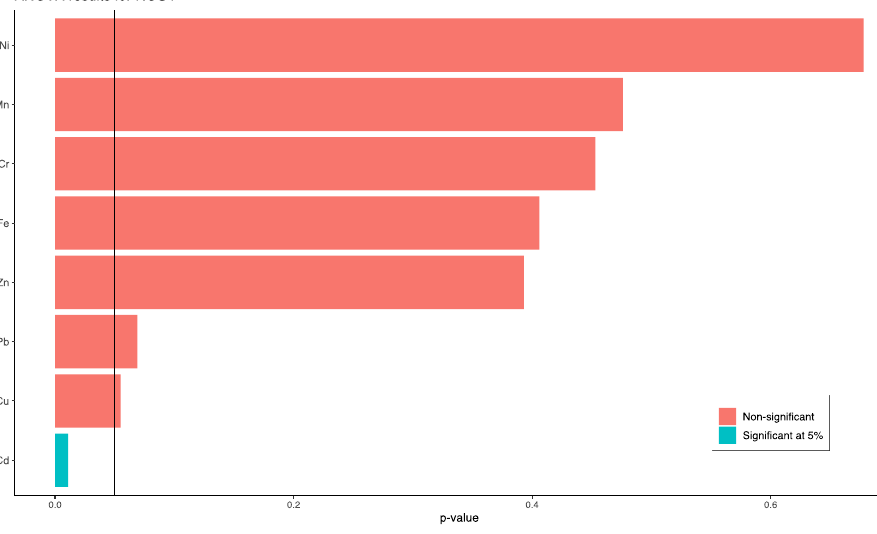
Figure 7. The results of ANOVA for root parameters. Table 11. The content of heavy metals in the roots of Daucus carota subsp. sativus growing in six allotment gardens of Gorz ó w